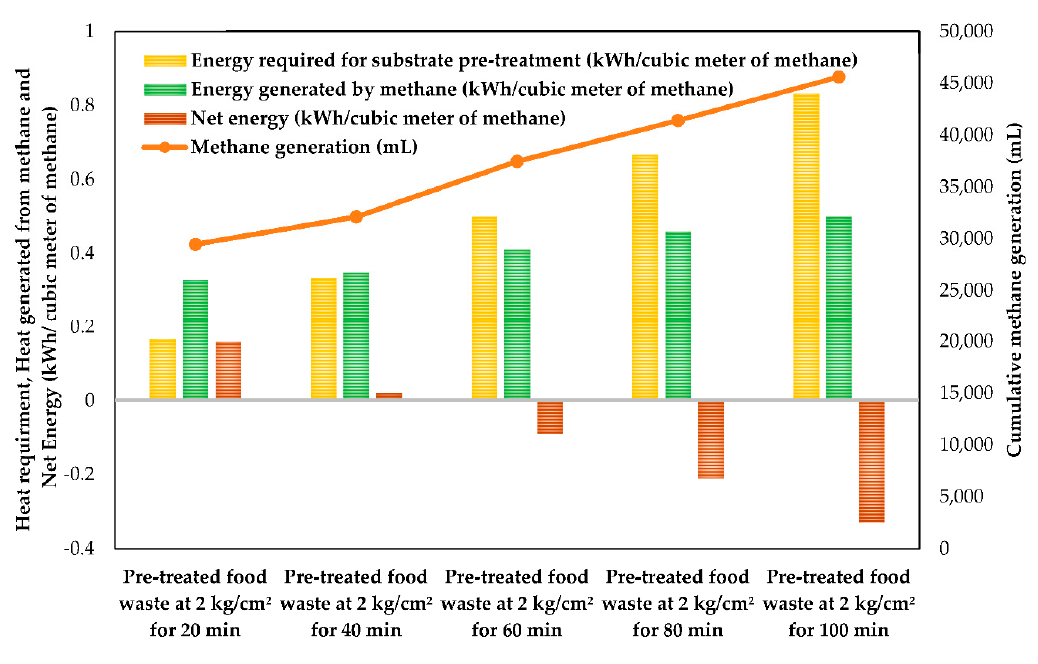
Figure 10. Heat energy required and generated along with net energy for pretreatment of food waste at 2-kg/cm 2 pressure and different time durations.